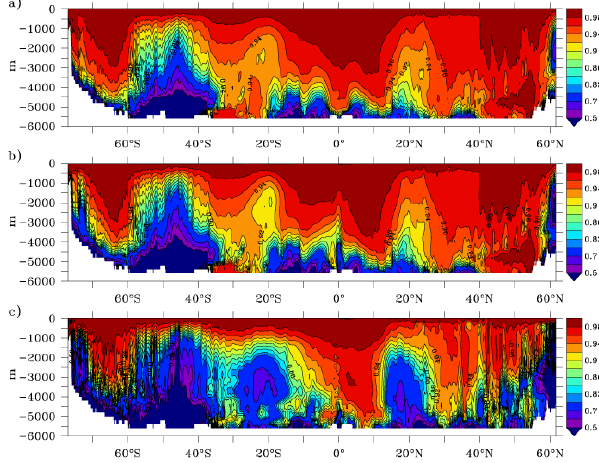
Fig. 9. As Fig. 8 (a) , (b) , (c) but for global